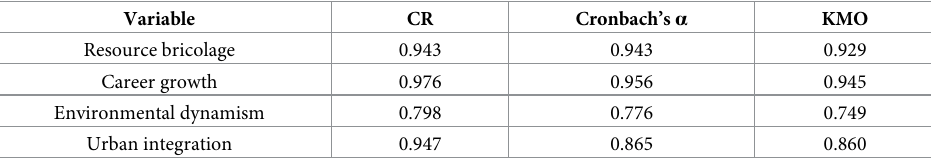
Table 3. Reliability and validity